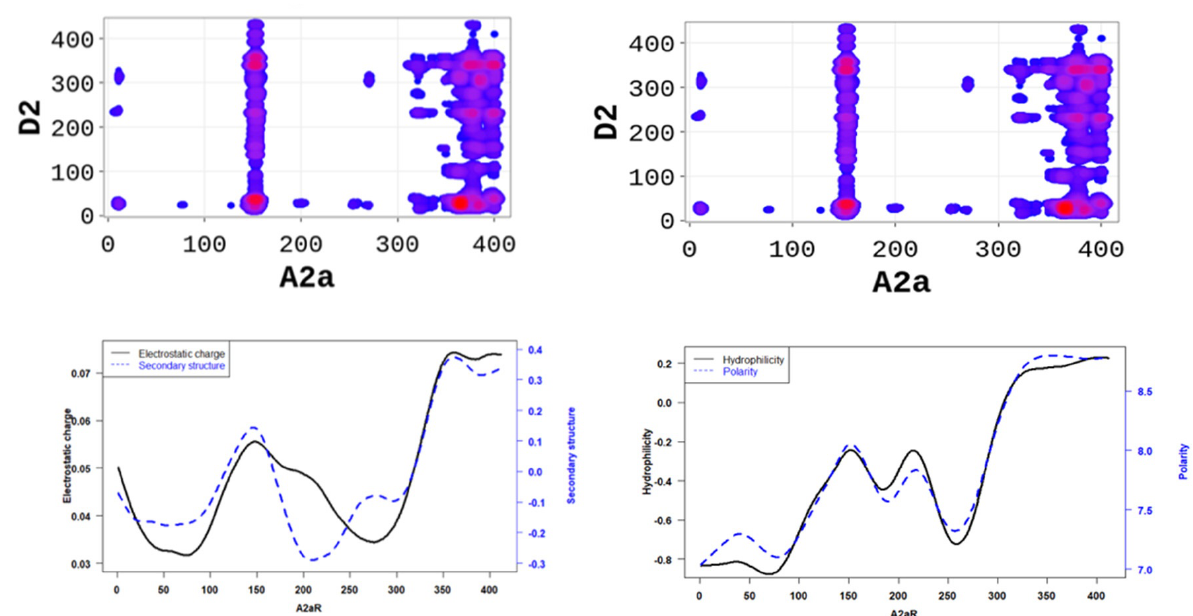
Figure 2. A2aR/D2R dimerization is driven by the secondary structure A2aR and its electrostatic charges. On average, electrostatic charges and secondary structure similarity score (dominated by alpha-helix conformation) of amino acids are higher at the predicted hot-spots (left panel). We also observed that predicted interacting residues have high hydrophobicity and polarity scores (right panel).